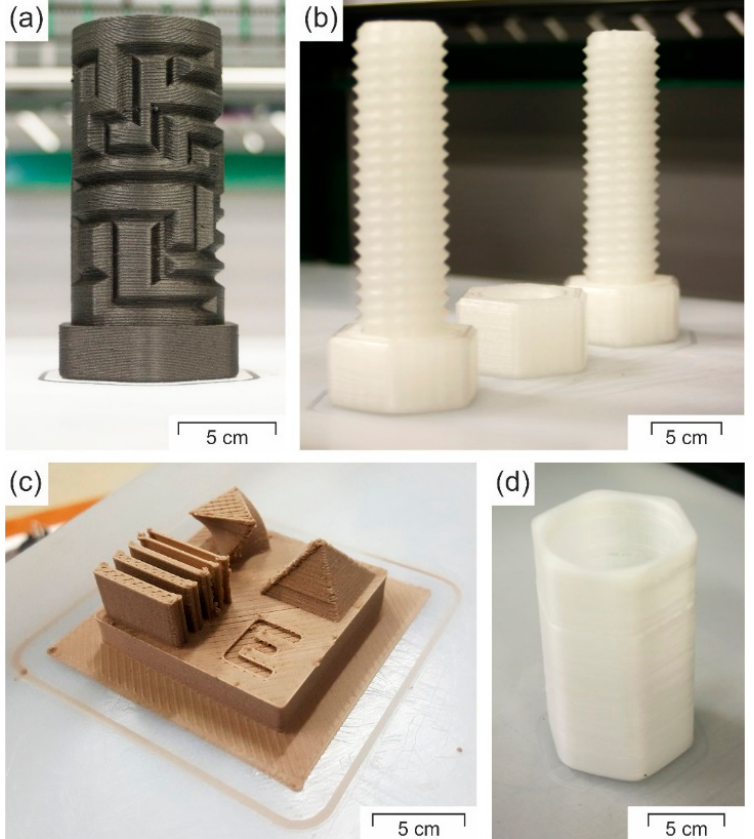
Figure 9. Representation of the practical usability of the sanded UHMW-PE plate as a build platform material for PP-based materials: hPP filled with carbon fibres [11] ( a ); unfilled PP random copolymer (rPP) [8] ( b ); PP-composite [8] ( c ); and neat hPP [9] ( d ). All printed specimens are represented directly after the finalisation of the print, when still in contact with the UHMW-PE build platform.